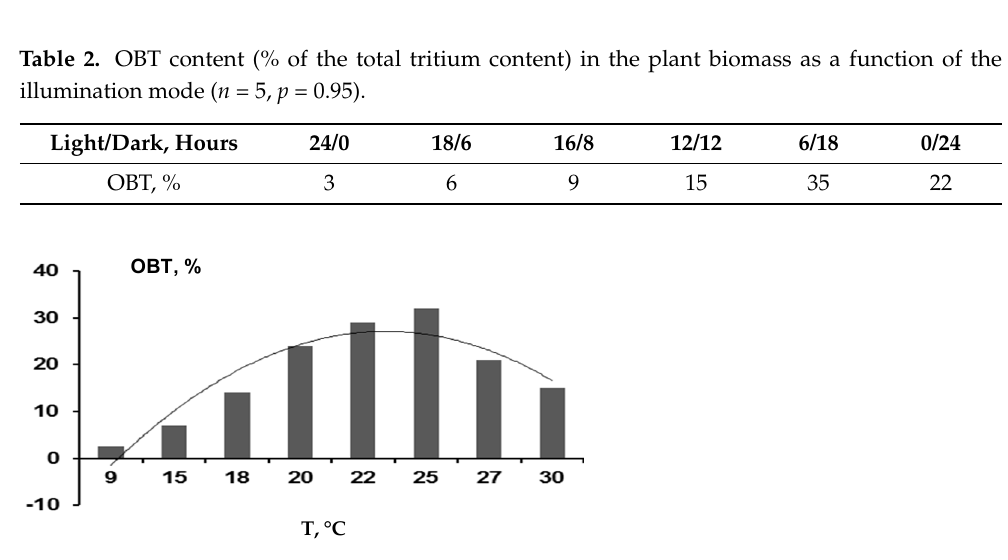
Figure 2. Dependence of the proportion of the OBT content (percentage from the tritium activity accumulated in the biomass) in the plant biomass on the ambient temperature. Table 2. OBT content (% of the total tritium content) in the plant biomass as a function of the illu- mination mode ( n = 5, p = 0.95).